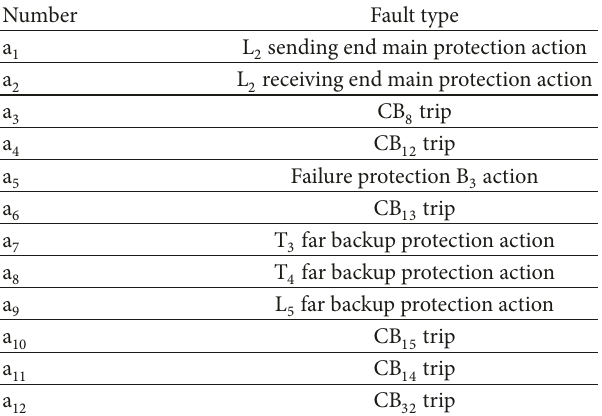
Table 4: The code of alarm